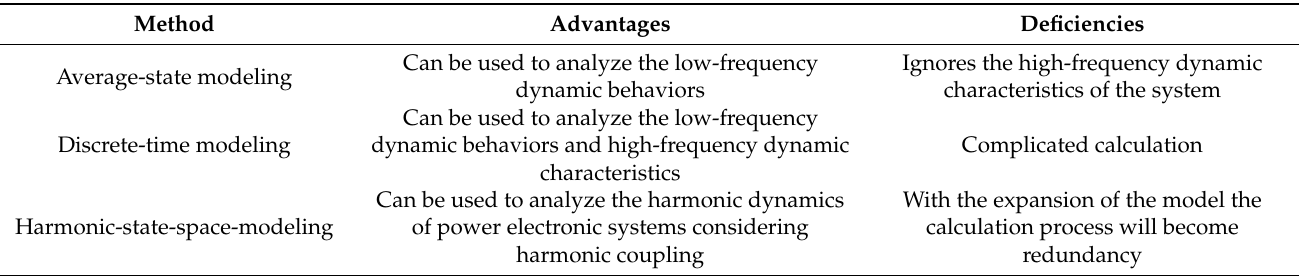
Table 8. Comparisons on the modeling methods of complex dynamic